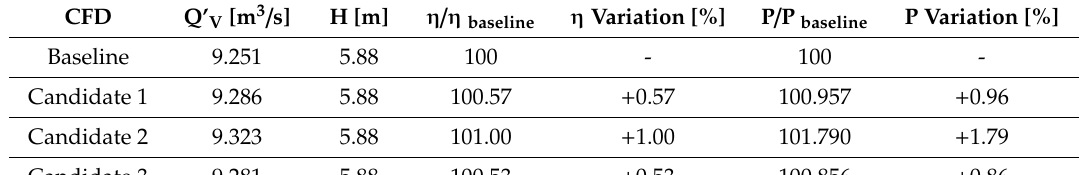
Table 3. Full machine CFD results (transposed based on baseline CFD results).